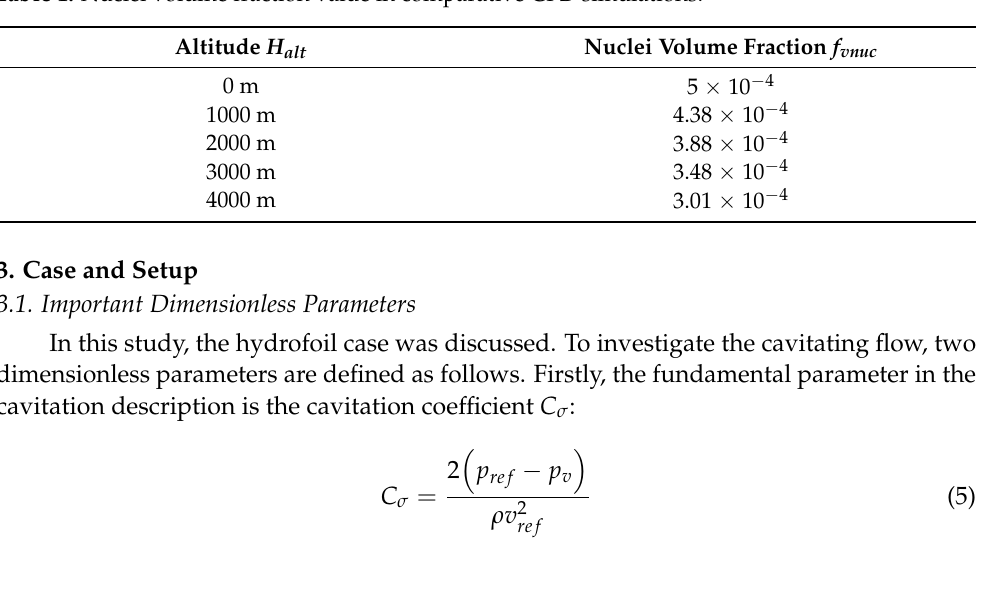
Table 1. Nuclei volume fraction value in comparative CFD